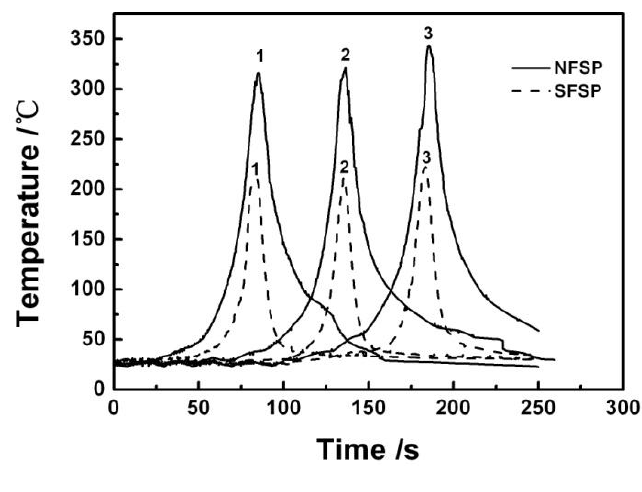
Figure 1. Temperature profiles during FSP of AZ31 magnesium alloy (1, 2, and 3 are the locations mentioned in Figure 11).